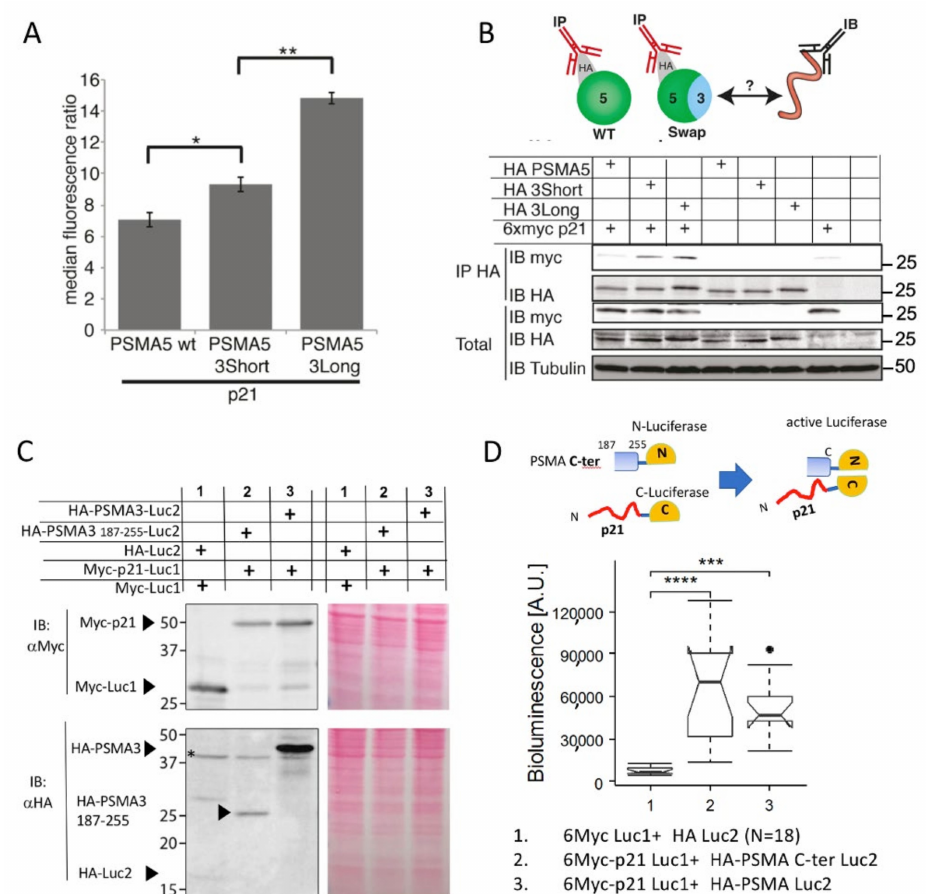
Figure 3. The PSMA3 C-terminus is sufficient to interact with p21. ( A ) Cells were transfected with the PSMA5 and three chimera (see Figure S3) together with p21-VFP and fluorescence intensities of at least 10,000 cells for each case were monitored and recorded by flow cytometry. PSMA5-3short is made of PSMA5 amino acids 1–187 with PSMA3 (187-229 aa) at its c-terminus. PSMA5-3long is as above but the PSMA3 fragment is longer (187–255 aa). Standard deviation bars represent three independent experiments. * p = 0.03, ** p = 0.001 using a two-tailed Student t test. ( B ) Schematic illustration of the experimental strategy with the antibodies used for immunoprecipitation (IP) or immunoblotting (IB), the latter to detect myc-tagged p21. HEK293 cells were transiently transfected as indicated with 6xmyc p21 and chimeric PSMA5 subunits. Cells were harvested 48 h post-transfection, lysed and subjected to IP with HA beads to immunoprecipitate chimeric PSMA5 subunits. Total lysate and IP samples were analyzed by SDS–PAGE and immunoblotting. ( C ) Representative SDS–PAGE and immunoblot analysis of the overexpressed proteins that were tested for interaction. Ponceau staining was used as a loading control. * non-specific band ( D ) The scheme of divided luciferase experiment is shown above the obtained data analyzed by Boxplot representing the overall bioluminescent signals corresponding to interaction between p21 and either PSMA3 or PSM3 187–255. The samples are numbered based on Panel C. n = 14–18. *** p ≤ 0.001, **** p ≤ 0.0001, using a two-tailed Student t